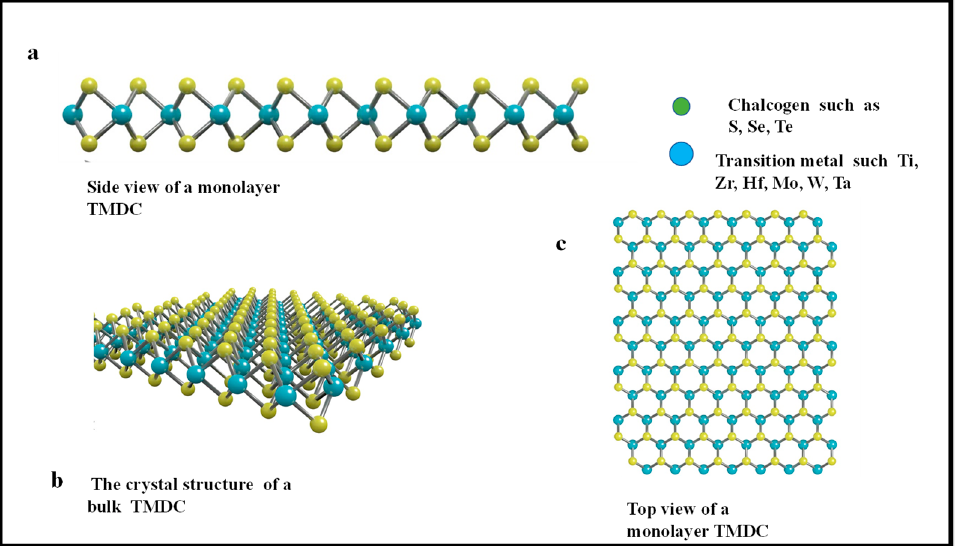
Figure 2. Crystal structure of a TMDC ( a ) side view of a monolayer; ( b ) bulk TMDC; ( c ) top view of a monolayer.